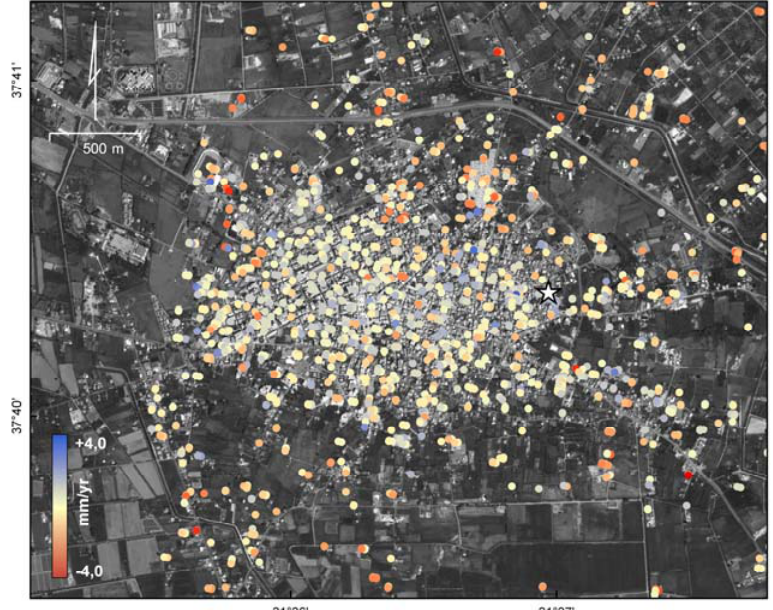
Figure 5. Linear component of ground deformation obtained by IPTA over Pyrgos city. Point targets plotted on a QuickBird Pan–Sharpened image. The star on the image refers to the location of the reference